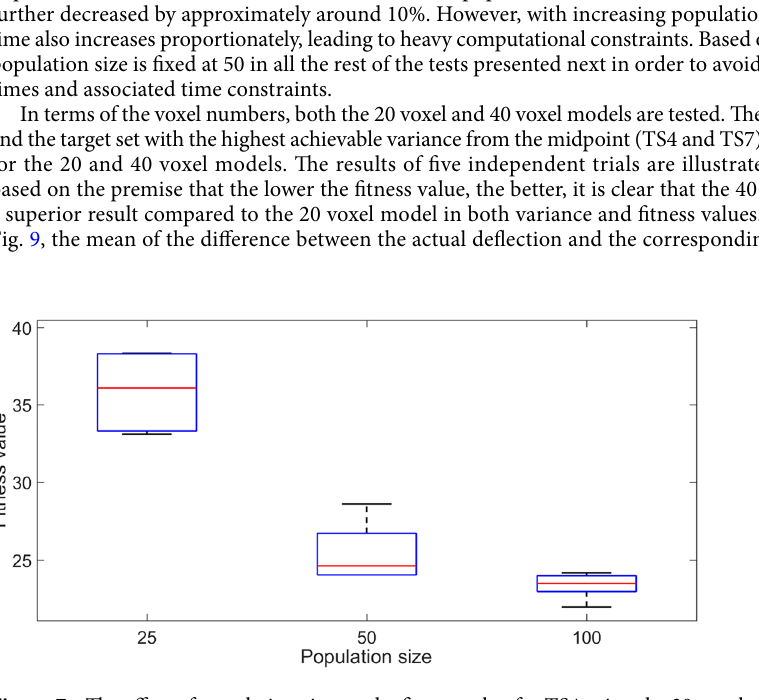
Figure 7. The effect of population size on the fitness value for TS4 using the 20 voxel single symmetric model. The solid lines in the middle indicate the median fitness value, and the boxes represent the 25th and 75th